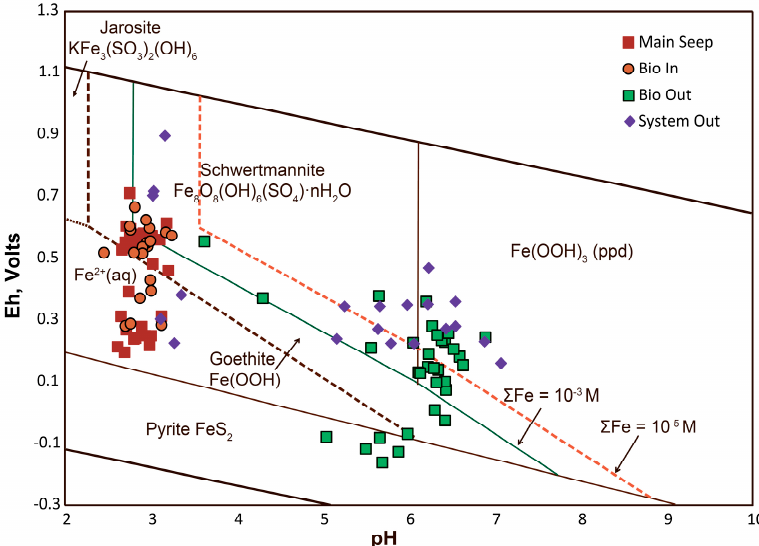
Figure 7. Eh–pH diagram for Fe-S-K-O-H system at 25 °C. Stability fields for the mineral phases were plotted using available thermodynamic data from Bigham and Nordstrom [29]. Plotted data represent water samples collected at the Main Seep, Bioreactor Inlet (Bio In), Bioreactor Outlet (Bio Out), and System Outlet (System Out).